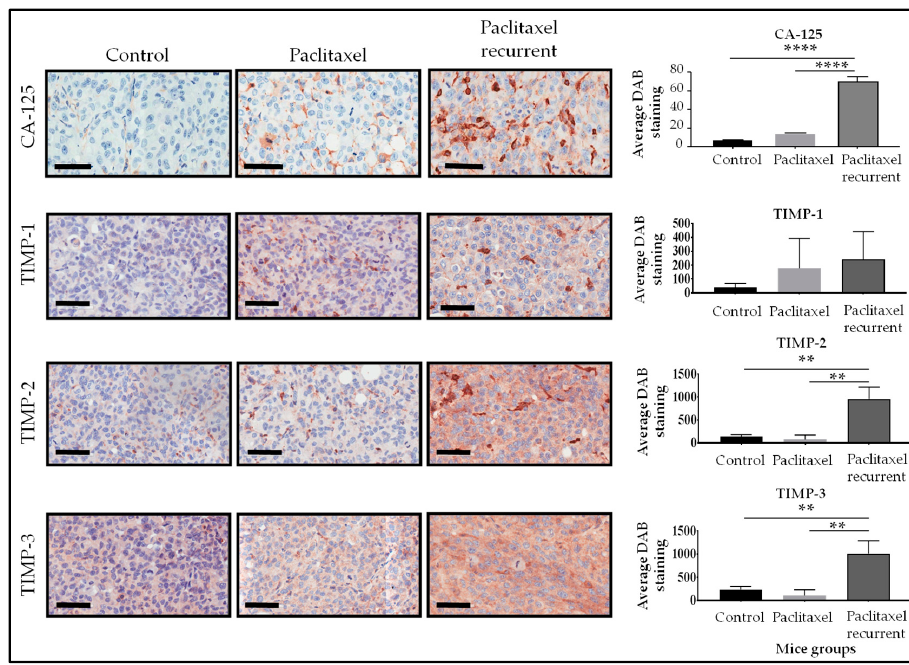
Figure 4. Representative images of TIMP-1, TIMP-2, TIMP-3 by immunohistochemistry staining in paraffin embedded tumor xenografts derived from mice in control, groups 1 and 2 was performed as described previously [33]. Animal experiment was carried out in strict accordance with the recommendations in the Guide for the Care and Use of the Laboratory Animals of the National Health and Medical Research Council of Australia. The experimental protocol was approved by the University of Melbourne’s Animal Ethics Committee (Project-1413207.1, 14 July 2014). Quantification of immunohistochemical staining of TIMP-1, -2 and -3 was performed as described previously [238]. Data is presented as mean ± SEM ( n = 3 control mice, n = 3 xenografts from mice treated with paclitaxel, groups 1 and 2). Magnification 400×, scale bar = 60 µm. Significance is indicated by ** p <0.01; **** p <0.0001.